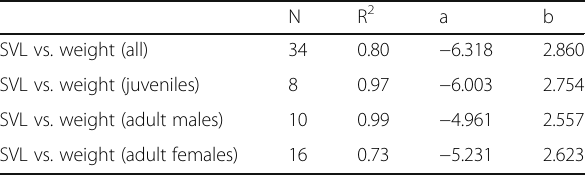
Table 2 Sample sizes, parameter and coefficient of determination (R 2 ) of the regression: logW = loga + b ∙ logSVL of blunt-nosed vipers from Cyprus N R 2